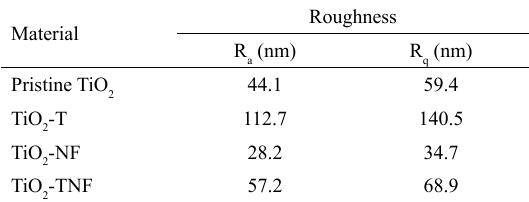
Table 1. Roughness measurements for TiO supported on stainless steel.